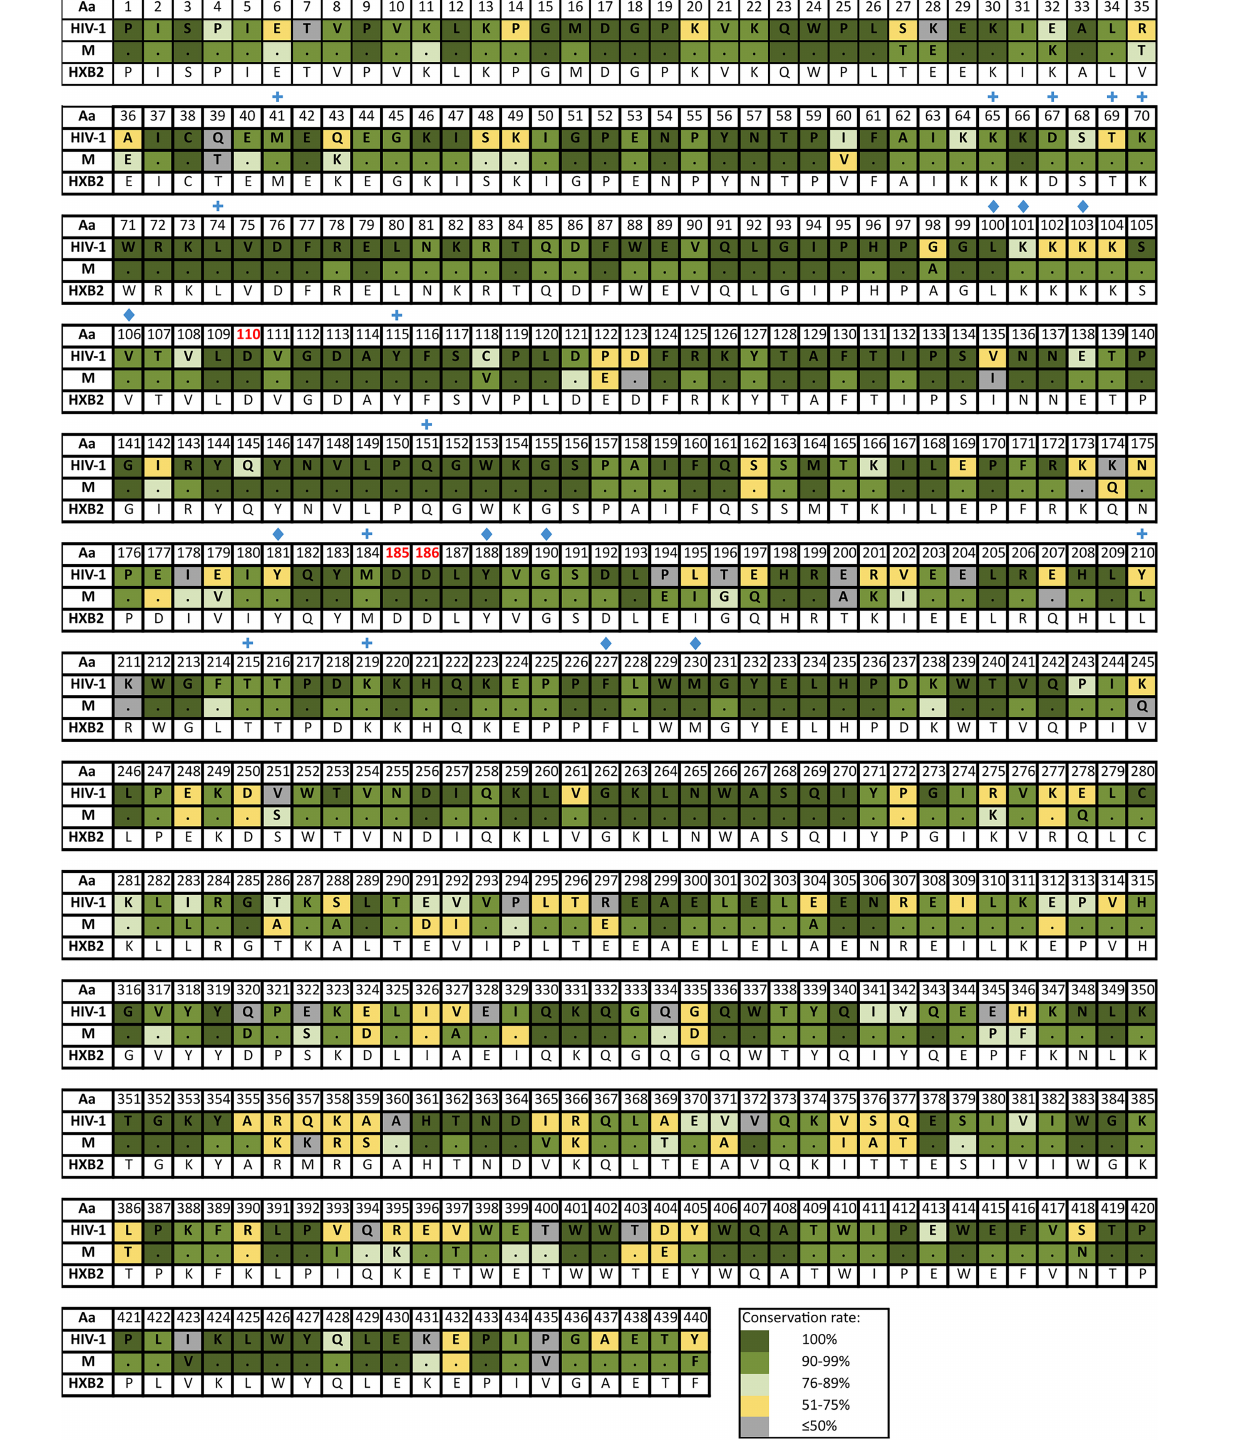
FIGURE 4 | Amino acid conservation rate along RT in HIV-1 and group M consensus. Aa, amino acid; M, group M consensus. RT, reverse transcriptase (440 aa). Dots in group M represent the same aa as in HIV-1 consensus for that position. HXB2 reference sequence is described below the groups for further guidance. Colors represent the conservation rate. Residues of the catalytic triad (Asp110, Asp185, and Asp186) are highlighted in red font. Blue crosses and blue diamonds indicate positions where DRM to NRTI and to NNRTI, respectively, are located according to Stanford v9.0 (Release Notes - HIV Drug Resistance Database, 2020). Aa code according to Figure 3